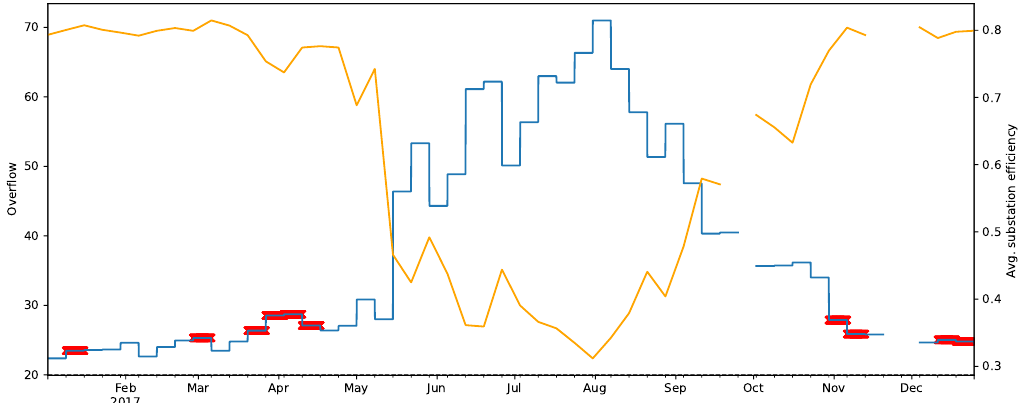
Figure 5. Example of well and sub-optimally performing substations in 2017. Overflow vs. substation efficiency. Due to missing values, some of the weeks are